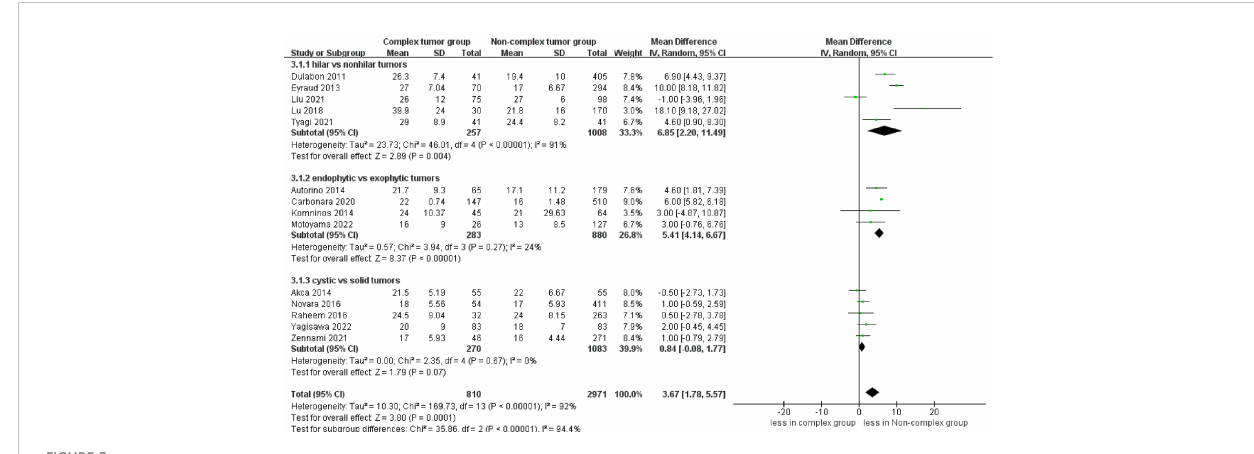
FIGURE 3 Forest plots of perioperative outcome- warm ischemia time.